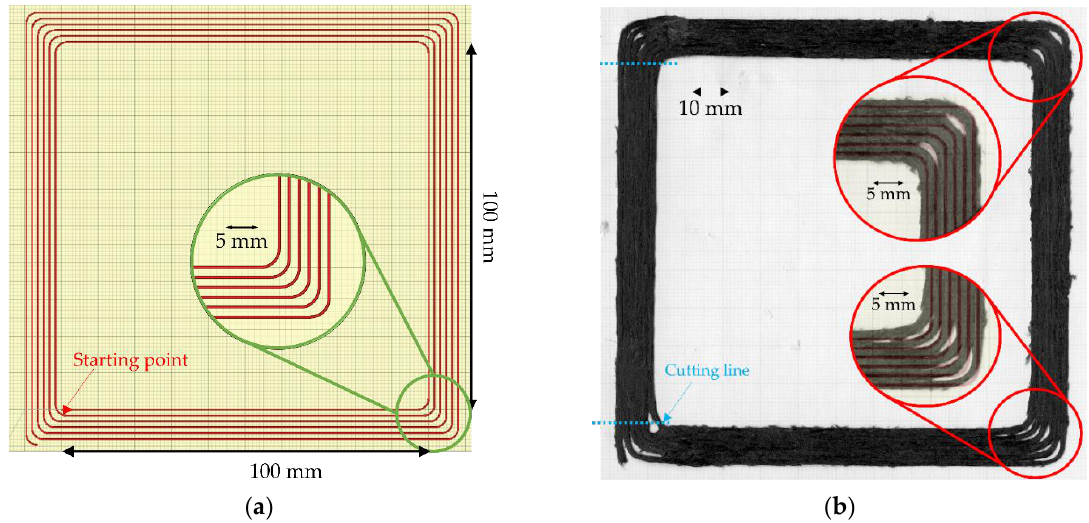
Figure 16. ( a ) Printing path of large square spiral with 3-mm turning radius at the corners; ( b ) top surface of the radius printed part with a zoom-in of a corner.